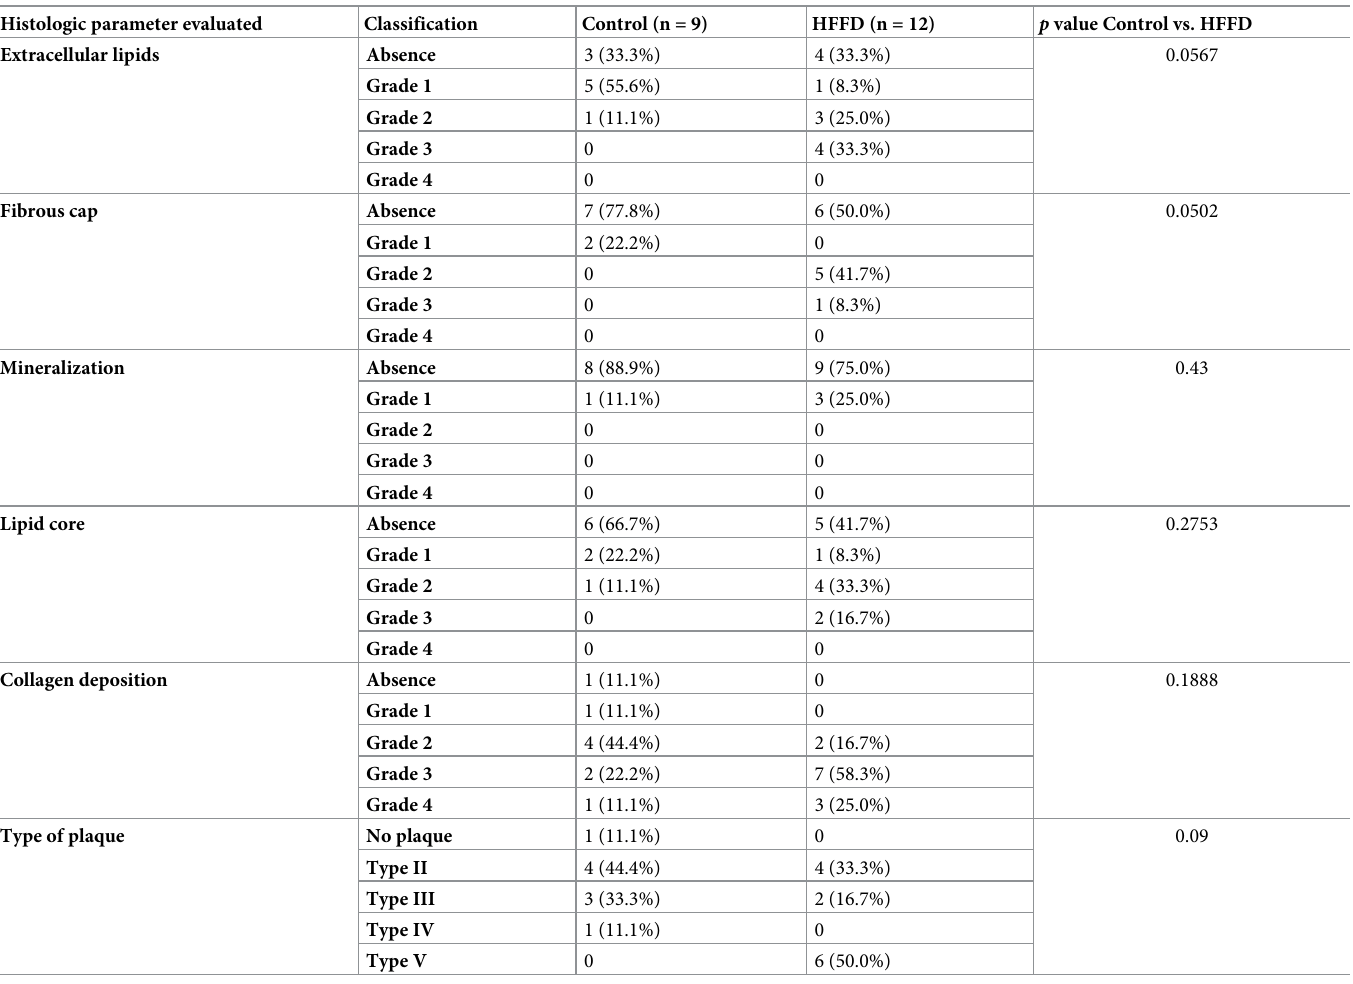
Table 2. Classification of atheroma